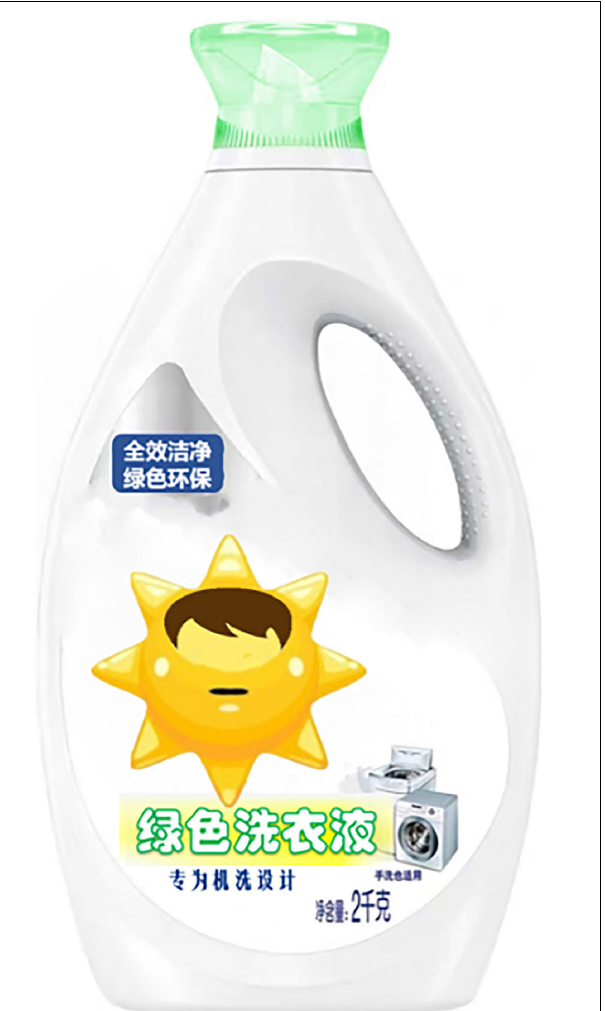
FIGURE 3 | Anthropomorphic strategy without